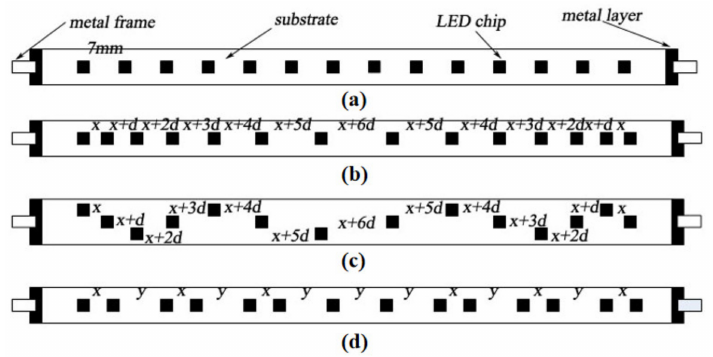
Figure 8. Model diagrams of packages with different chip distributions: ( a ) equidistant distribution; ( b ) arithmetic distribution; ( c ) S-type distribution; ( d ) combination-type